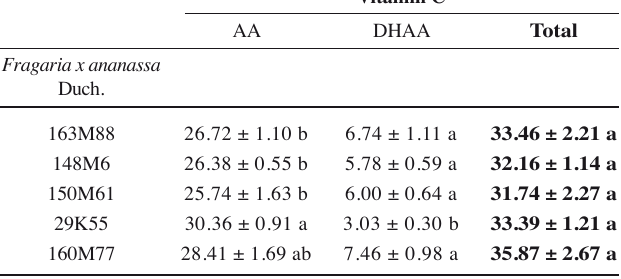
Tab. 3: Ascorbic acid (AA) and dehydroascorbic acid (DHAA) contents. Results are expressed as mg per 100 g FW (mean ± SD, n=3). Values with different letters showed statistically significant